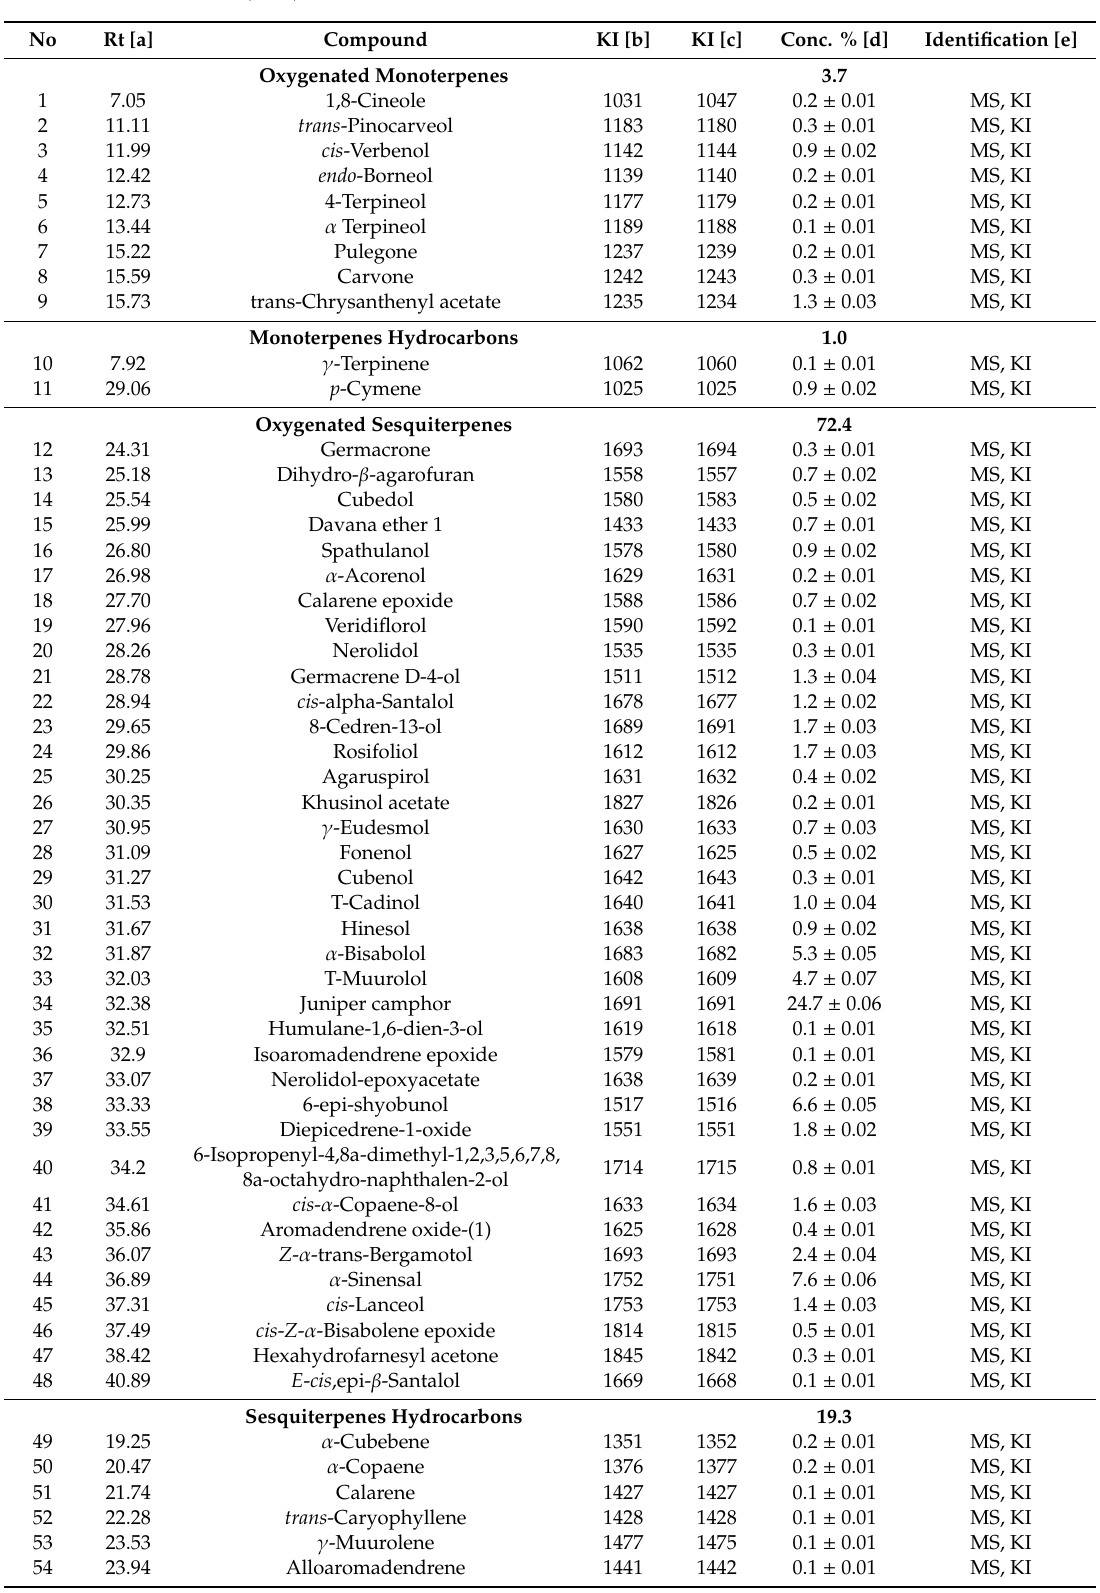
Table 1. Chemical constituents and concentration of the essential oil from the above-ground parts of Pulicaria somalensis